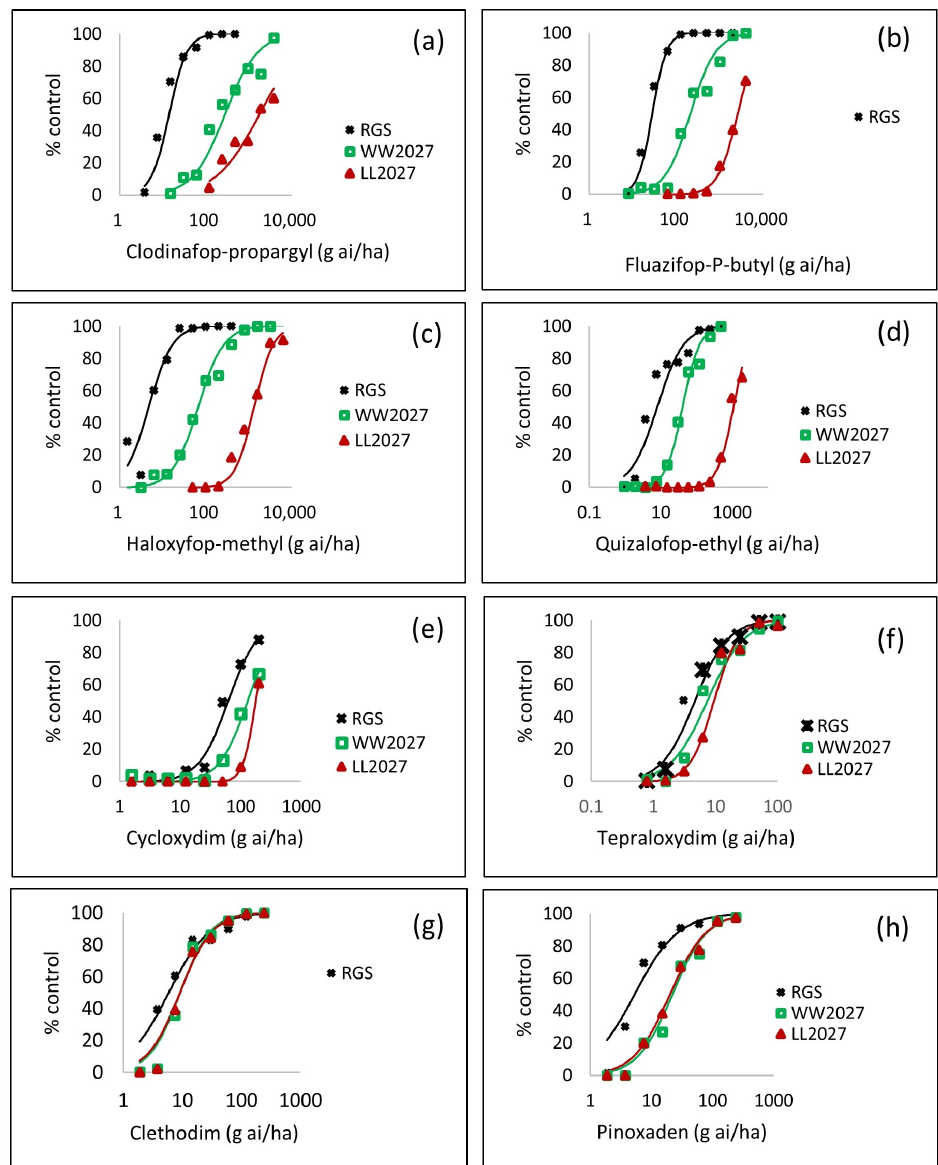
Figure 4. Whole plant dose–response test on three genotypes (RGS: standard sensitive, WW2027: homozygous wild type tryptophan, LL: homozygous mutant leucine and eight different ACCase-inhibiting herbicides: ( a ) clodinafop-propargyl, ( b ) fluazifop-P-butyl, ( c ) haloxyfop-methyl, ( d ) quizalofop-ethyl, ( e ) cycloxydim, ( f ) tepraloxydim, ( g ) clethodim, and ( h ) pinoxaden. The values plotted were back-transformed following analysis of logit transformed responses.